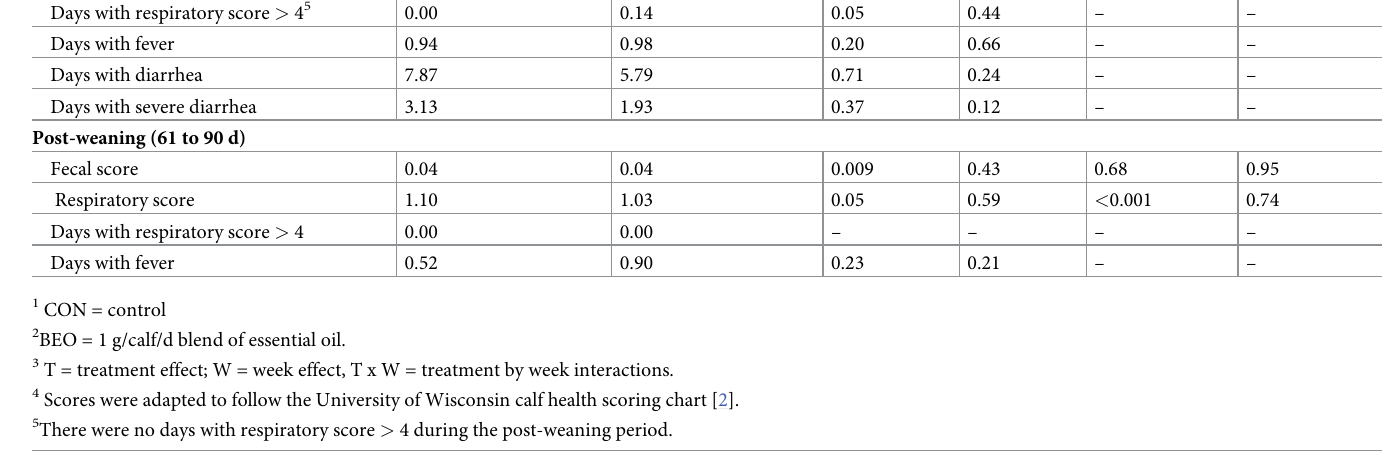
The supplementation of essential oils has already shown beneficial results for lowering diar- rhea and fecal scores in other species with the same efficiency of AGPs [18, 31, 70]. For piglets, where this is a prevalent disease and caused by similar agents as in calves, it has been shown favorable results with lower diarrhea prevalence for treated animals [70]. In our study, the average age for diarrhea (scores 2 and 3) occurrence was 12.2 ± 3.6 d for BEO and 13.6 ± 3.8 d for CON with no statistical difference ( P = 0.54). Diarrhea incidence on pre-weaning in BEO treatment was 85% against 93% for CON treatment with no statistical difference ( P = 0.68). The fecal score was different between treatments ( P = 0.04), with lower values for BEO, and changed over time ( P � 0.001, Table 7). Days with diarrhea (scores 2 and 3, P = 0.24) and days with severe diarrhea (score 3, P = 0.12) were not different between treatments (Table 7). Three animals of each treatment were medicated for diarrhea with anti-inflammatories, and the ther-